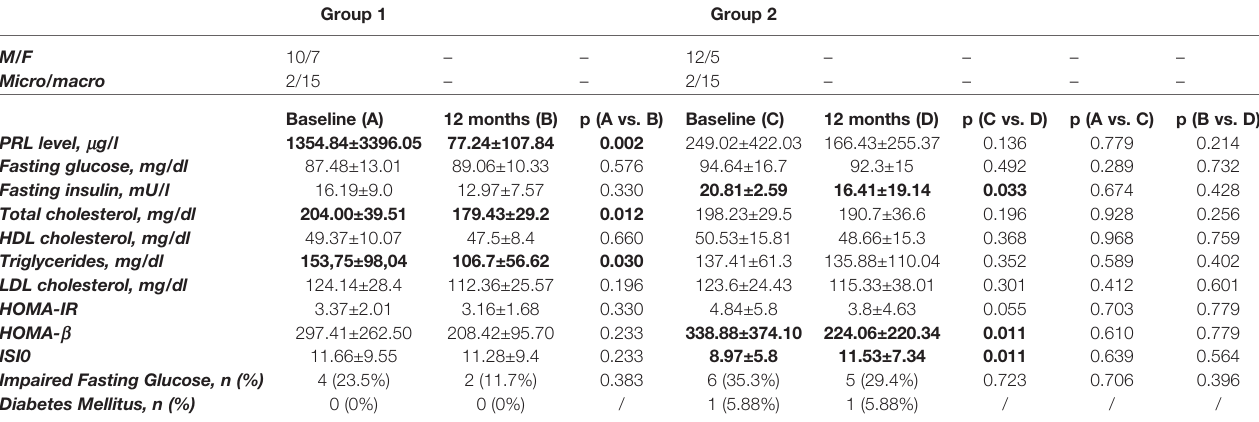
The bold values means statistically signi fi